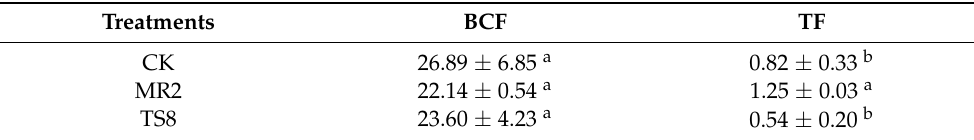
Table 3. Bioconcentration factors and translocation factors of M. floridulus grown in the Cd- contaminated soil inoculated with Lelliottia jeotgali MR2 and Klebsiella michiganensis TS8. Different letters represent significant differences between groups at the 5% level (ANOVA and Tukey’s